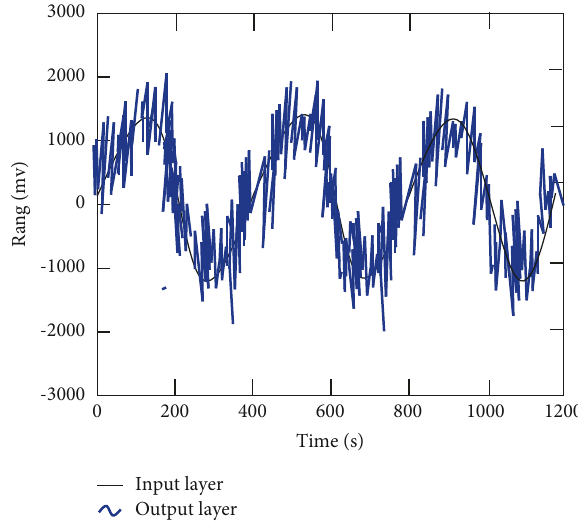
Figure 10: The effect diagram of S – K filter processing data.